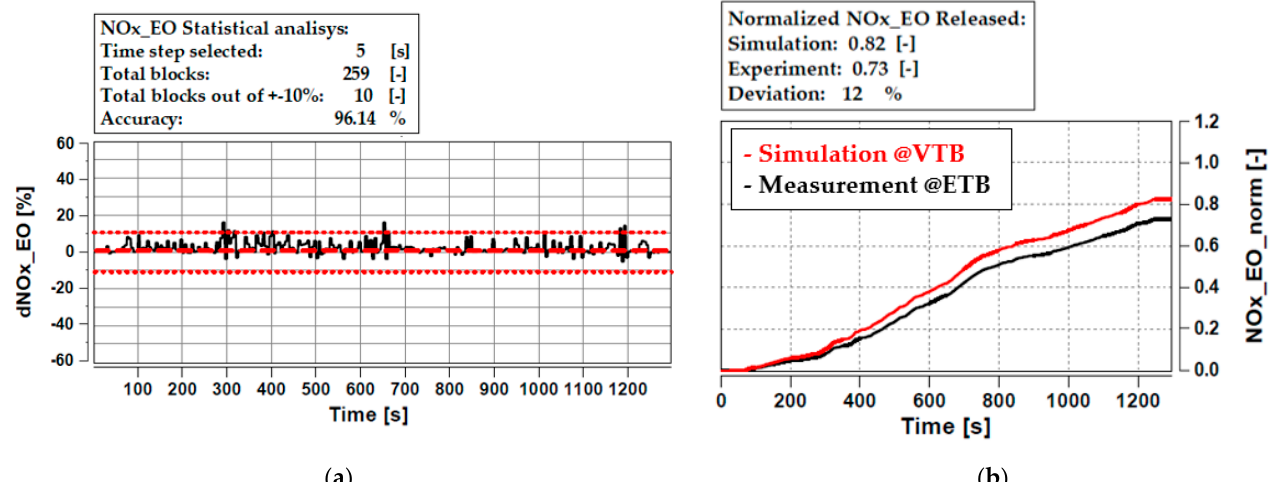
Figure 18. ( a ) Statistical analysis of NOx Engine Out simulated at VTB to determine the model accuracy over the NRTC; ( b ) Simulated (red) vs experimental (black) of cumulated NOx engine Out emission normalized with respect reference value.